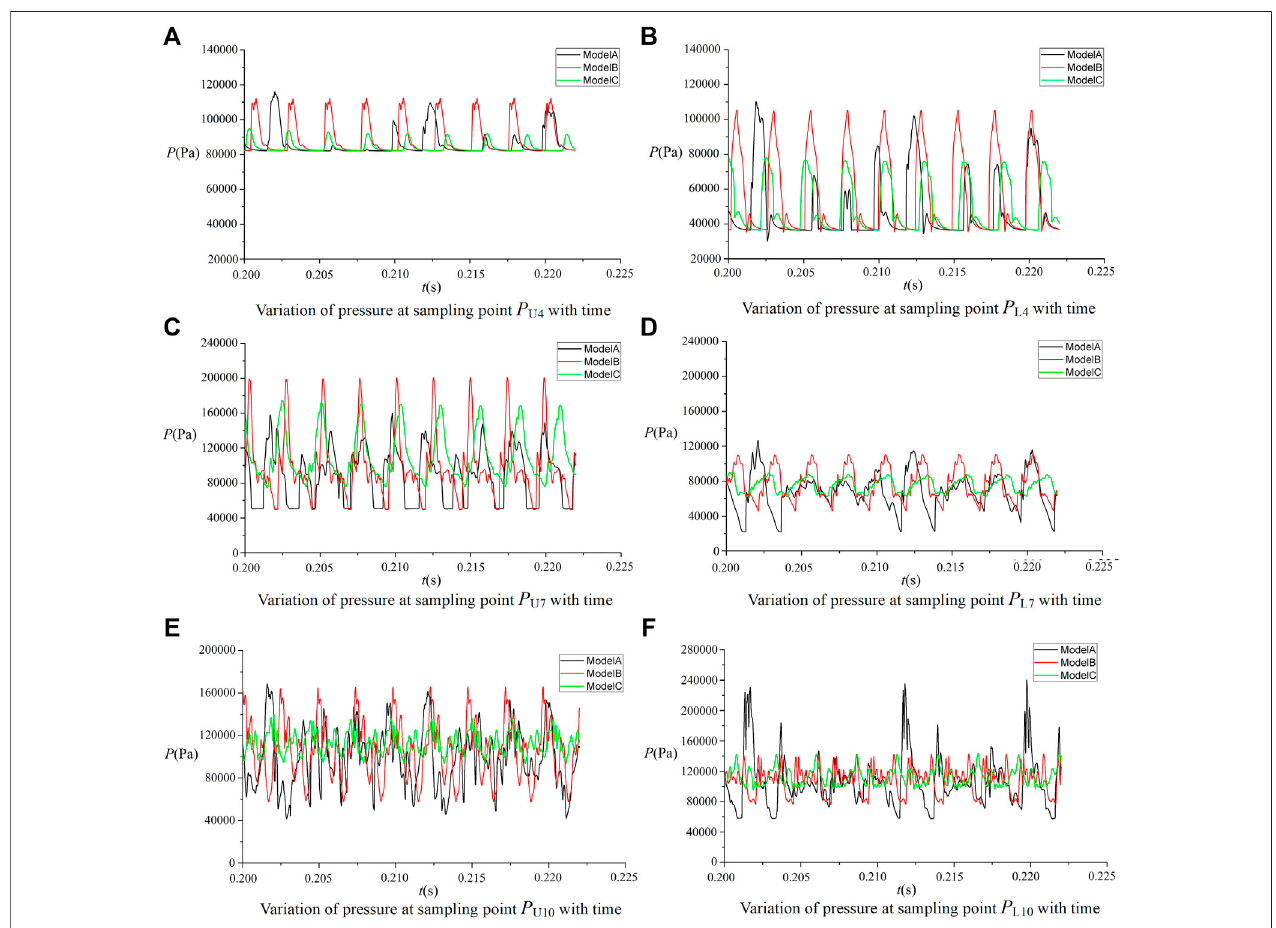
FIGURE 10 | Variation of the pressure at different sampling